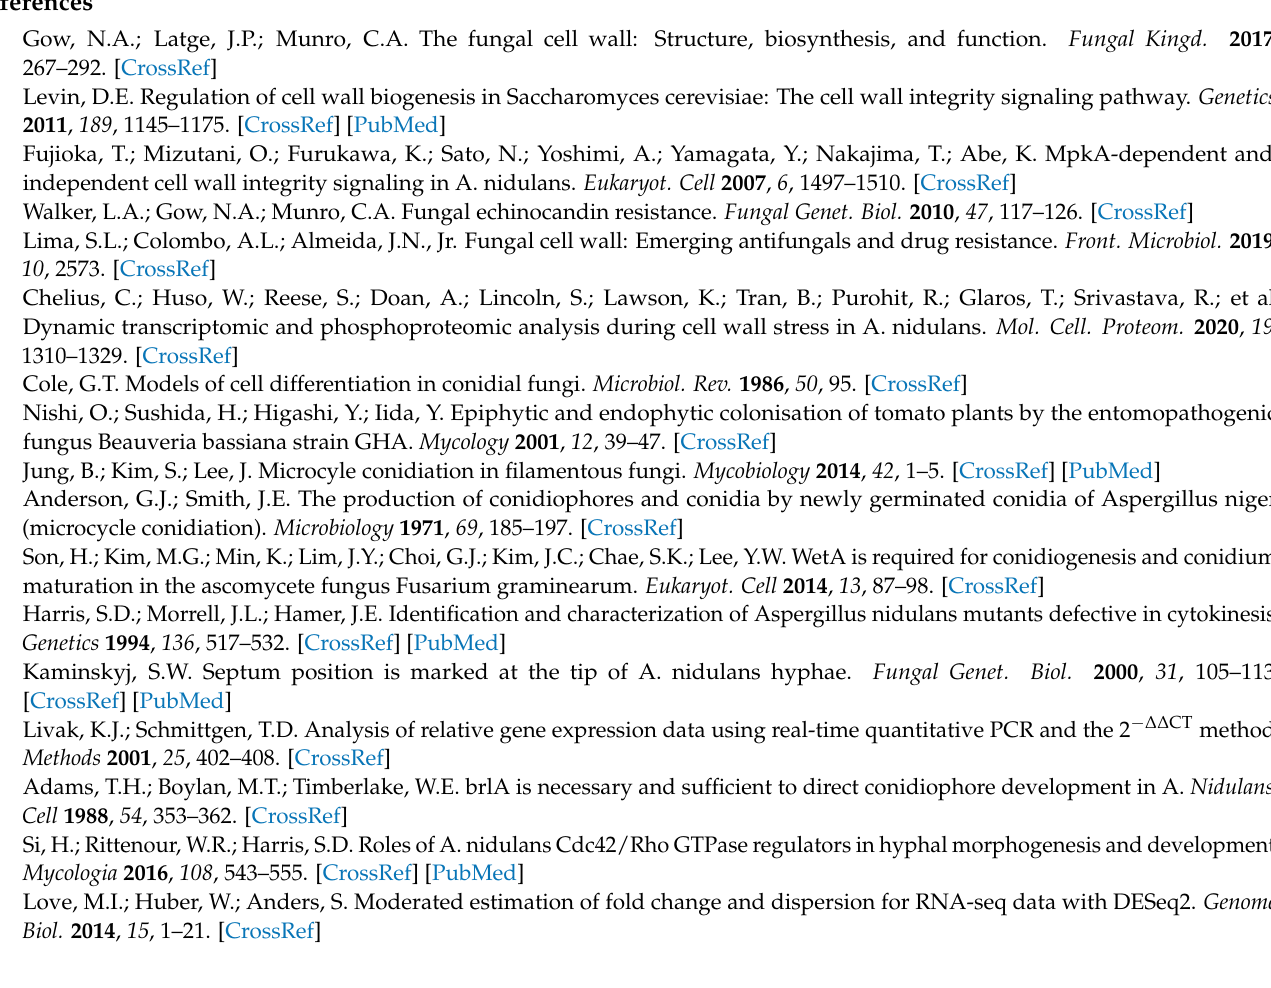
Table S1: Strains used in this study, Table S2: NCBI SRAs, Table S3: qRT-PRC Primers, Table S4: WT RNA-Seq Data, Table S5: KO RNA-Seq Data, Table S6: RNA-Sequencing DE Genes, Table S7: Gene Clusters, Table S8: Up-regulated GO Terms for